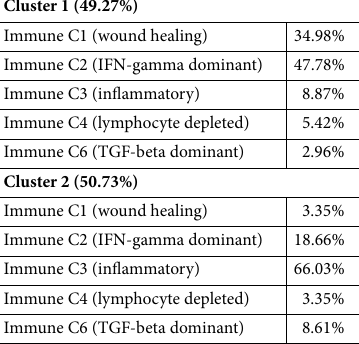
Table 2. The proportion of different immune subtypes of TCGA in clusters 1 and